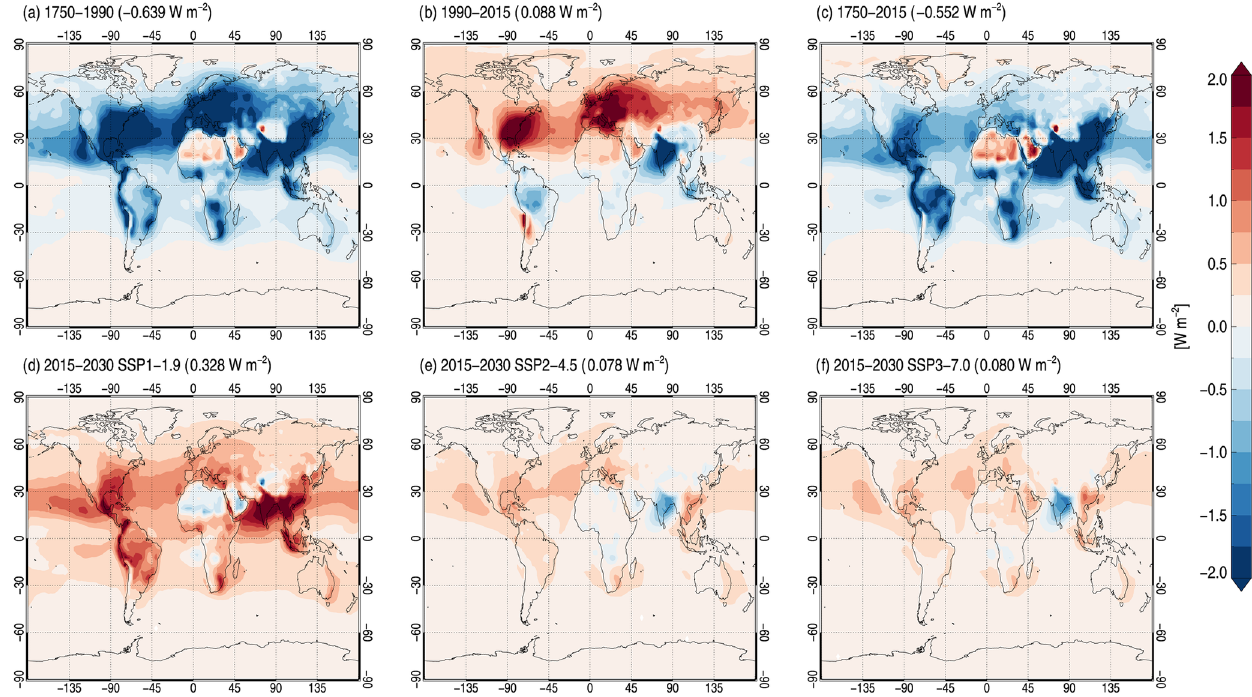
Figure 4. Total aerosol RF over four time periods: 1750–1990, 1990–2015, 1750–2015 and 2015–2030 for each of the three SSP scenarios considered